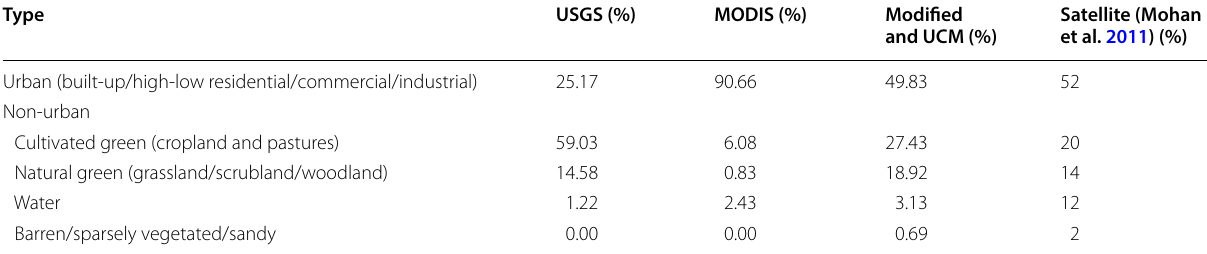
Table 1 Distribution of different land use types in input terrestrial data sets for WRF model